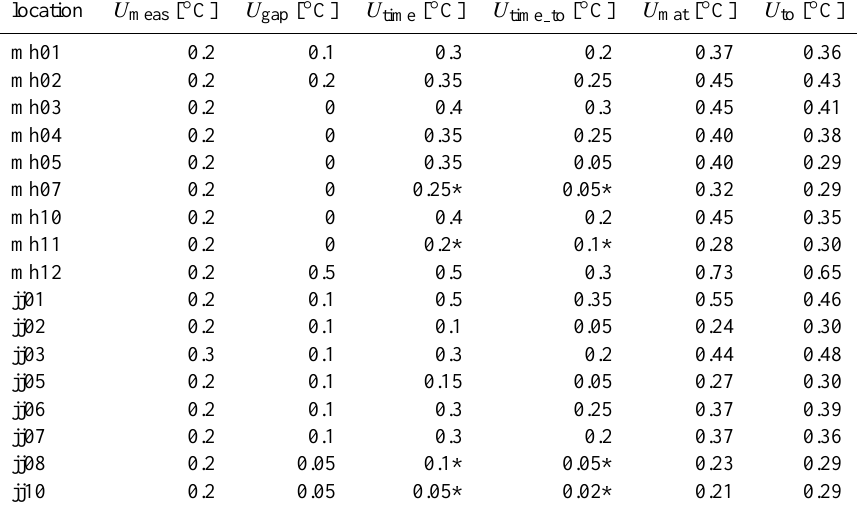
Table 2. Uncertainties of the MAT and the TO calculation. location U meas [ ◦ C] U gap [ ◦ C] U time [ ◦ C] U time to [ ◦ C]